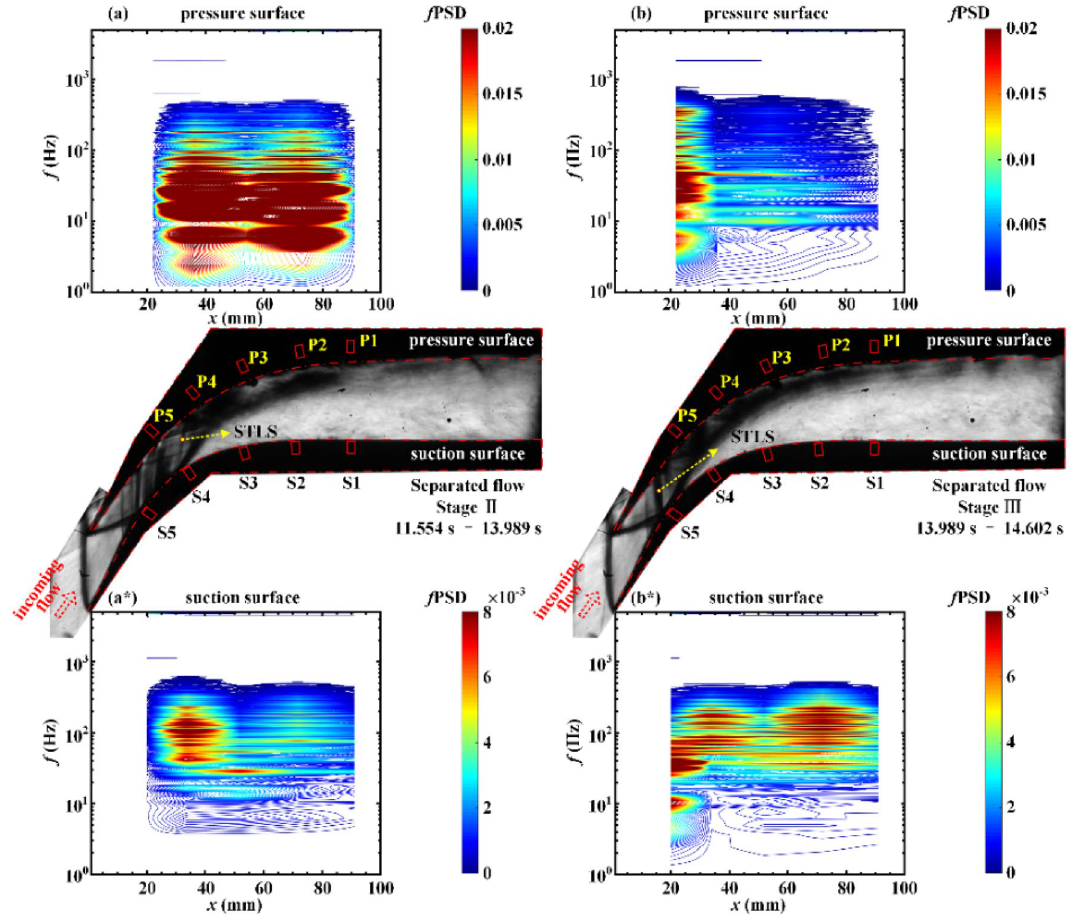
Figure 8. Contours of f PSD at the ( a ) pressure surface and ( a* ) suction surface in the separated flow during the period 11.554 s < t < 13.989 s. Contours of f PSD at the ( b ) pressure surface and ( b* ) suction surface in the separated flow during the period 13.989 s < t < 14.602